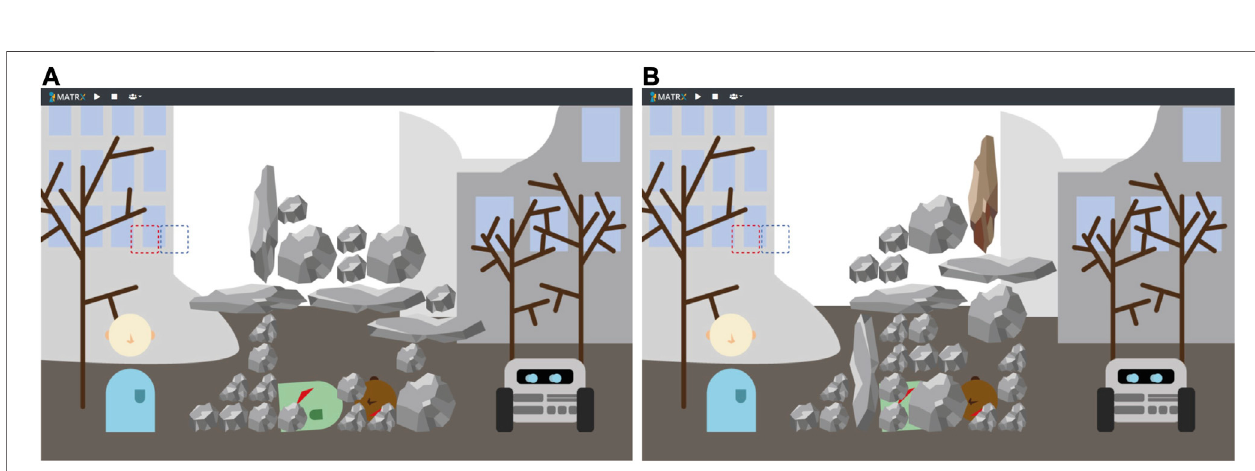
FIGURE 2 | The USAR task environment programmed in MATRX. It shows a victim underneath a pile of rocks, and a human and a robot representing the team members.Thedashed redsquare(above thehuman ’ shead)representsthehandofthehumanthatcanbemovedtopickuprocks.Thedashed bluesquarerepresents the hand of the robot. Scene (A) was used as level 1 in the experiment, while scene (B) was used as level 2.